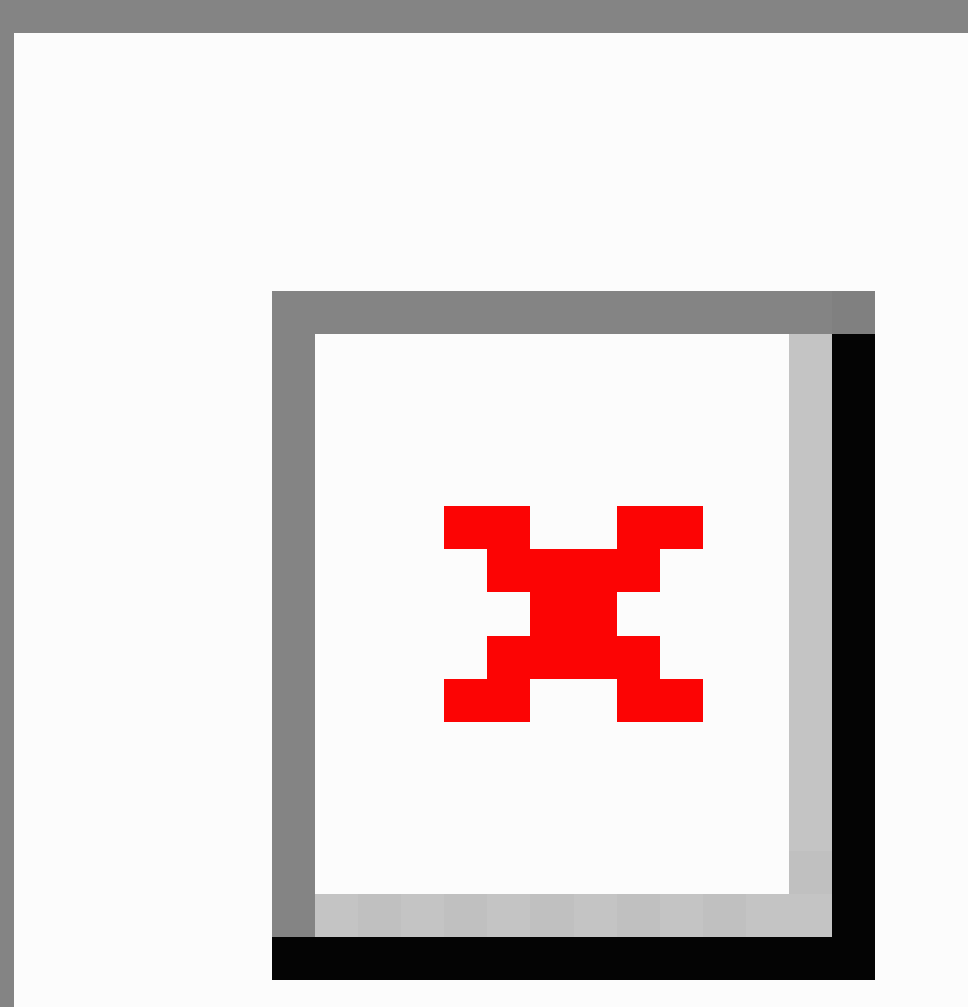
Figure 5. Equation for imbalance in the total numbers of subjects for two-way minimization method.